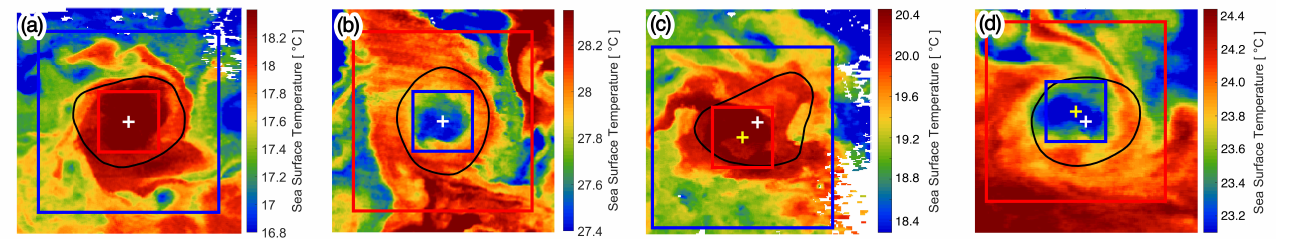
Figure 2. Examples of the eddy-core surface temperature anomaly computation and offset method. Snapshots represent Sea Surface Temperature in degrees. Black lines are superimposed altimetric detection contours. Small squares represent the core-mean and large ones represent the periphery- mean frames. Core-periphery values are coloured red-blue or blue-red based on the sign of δ T . Examples ( a – d ) illustrate the correction by offset: A white cross marks the centre of the image. A yellow cross marks the center of the core-mean and periphery-mean frames, if it differs from the centre of the image. Examples ( a , b ) are centred while ( c , d ) are